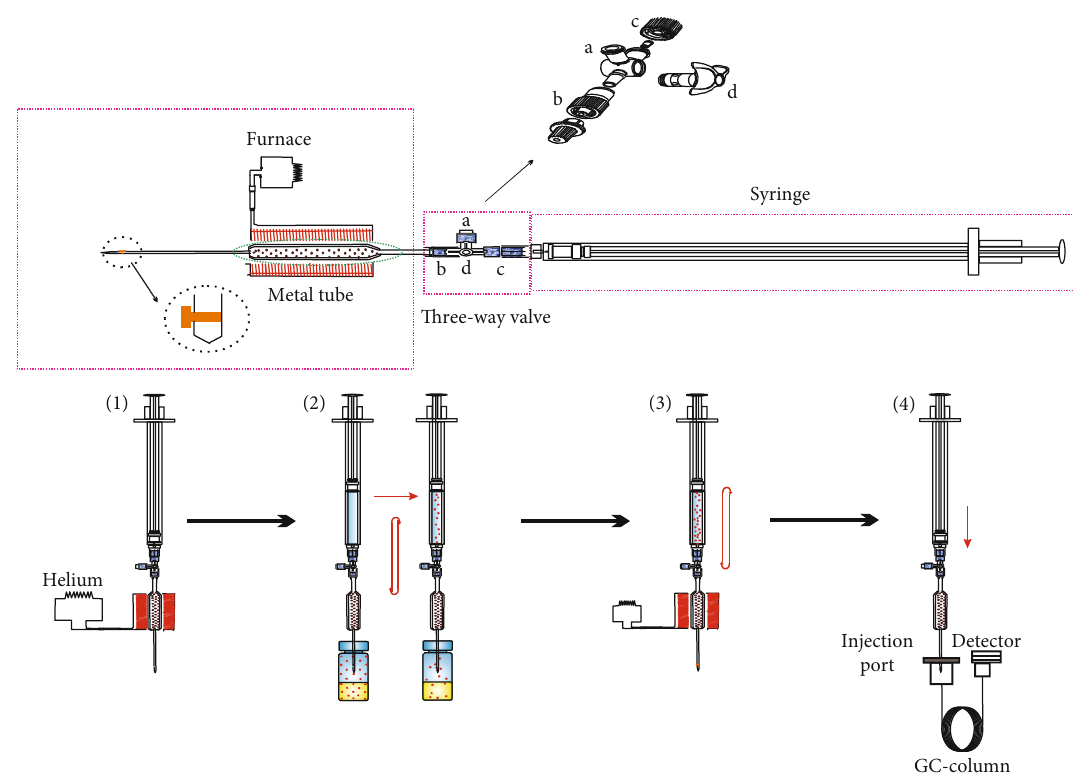
Figure 1: Diagram of SSPE structure and its operation procedure. The SSPE process has four steps: (1) heat the metal tube to ensure the adsorbent is completely puri fi ed; (2) extract the target hydrocarbon compounds through the natural gas sample; in this step, the sorbent is exposed to the sample and target analytes are separated from the sample matrix and adsorbed on the sorbents; (3) desorb the hydrocarbon compounds with the microfurnace; and (4) inject the hydrocarbons into the GC